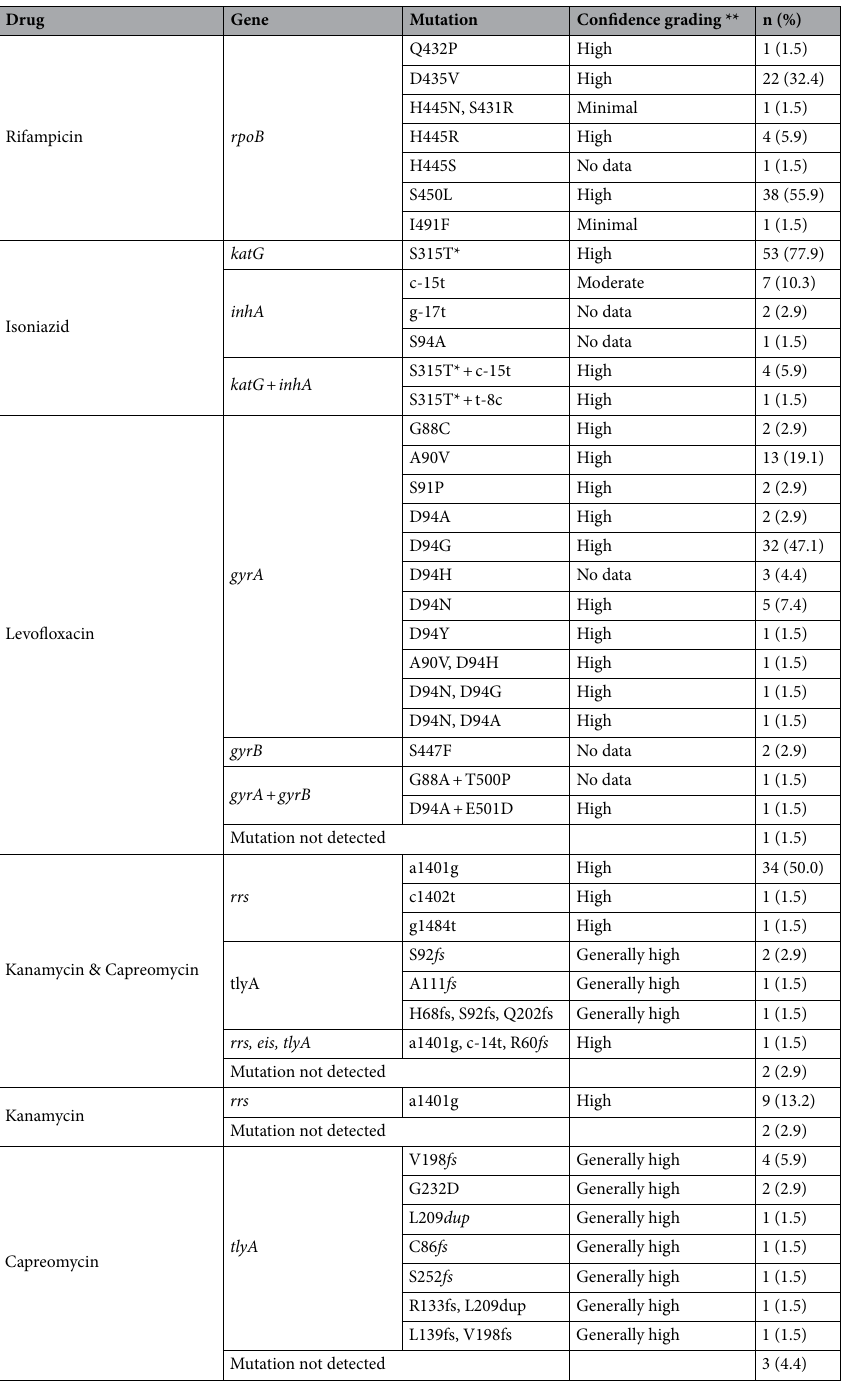
Table 2. Resistance-associated mutations in Peruvian XDR-TB strains. Codon numbering systems are according H37Rv genome (NC_000962.3). fs frame shift, dup duplication. *AGC → ACC. **According to WHO-NGS Technical guide 30 . The percentages are relative to the total of resistant strains for each